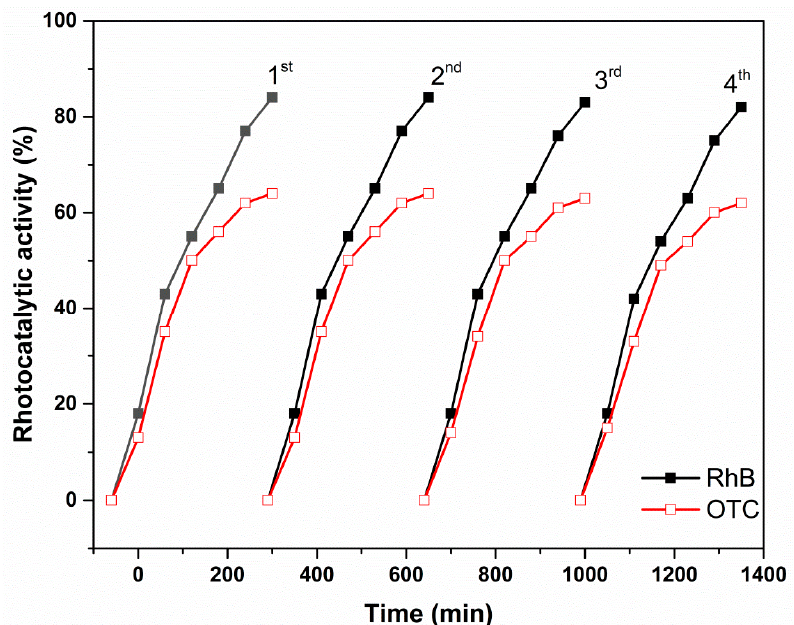
Figure 13. Photocatalyst stability test of the ZnO-Au1 nanocomposites for the photodegradation of RhB and OTC.